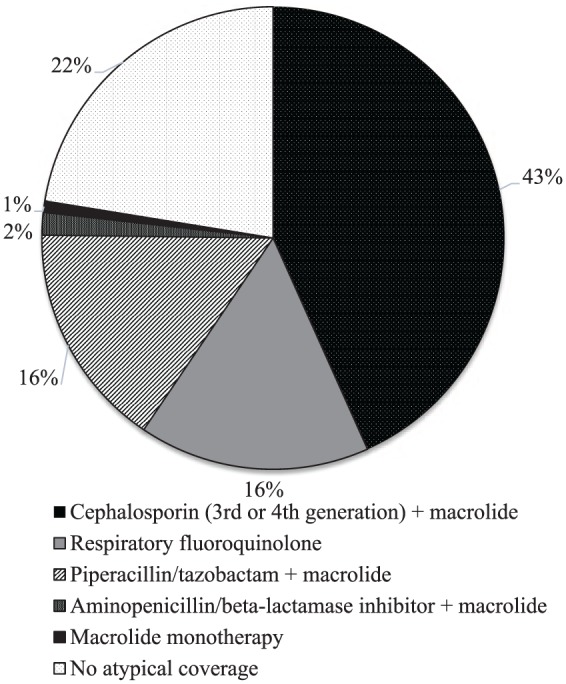
Empirical regimens.